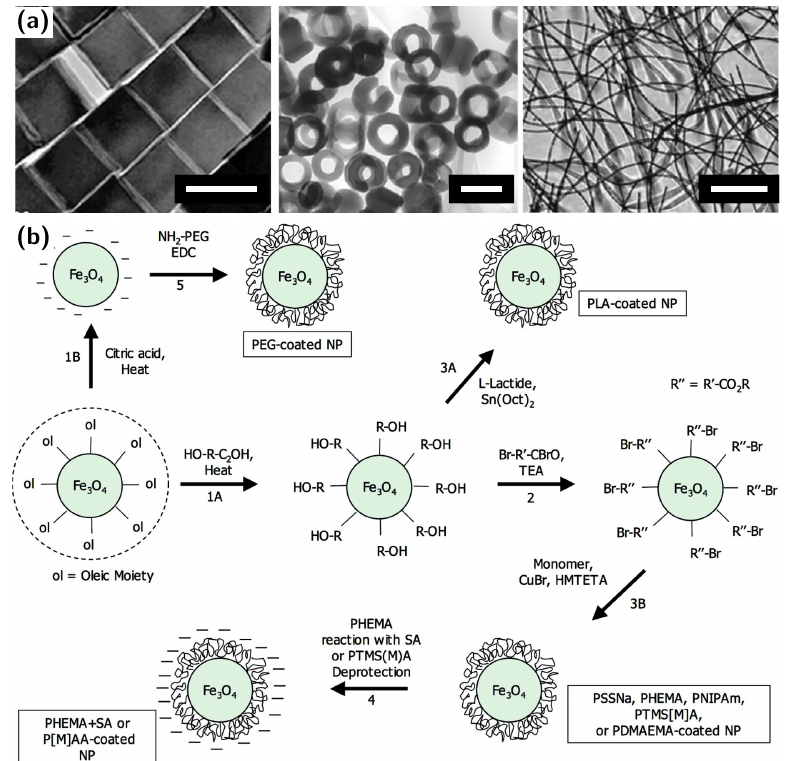
Figure 3. Functionalized magnetic nanoparticles for synthesizing ferromagnetic liquids. ( a ) Selection of iron oxide nanoparticle shapes: nanocubes, nanorings and nanowires, visualized with transmission electron microscopy. Scale bar (from left to right): 100 nm, 200 nm, 30 µ m. ( b ) Ligand functionalization of nanoparticles to promote interfacial assembly: 1A and 1B: ligand exchange reactions; 2: acylation of hydroxyl groups to prepare atom transfer radical polymerization (ATRP) surface initiators; 3A: surface-initiated ring opening polymerization of L-lactide; 3B: surface-initiated ATRP; 4: deprotection or additional reaction after polymerization; 5: grafting of end-functionalized polyethylene glycol (PEG) chains onto the nanoparticle surface using amidation chemistry. Figures ( a , b ) adapted from References